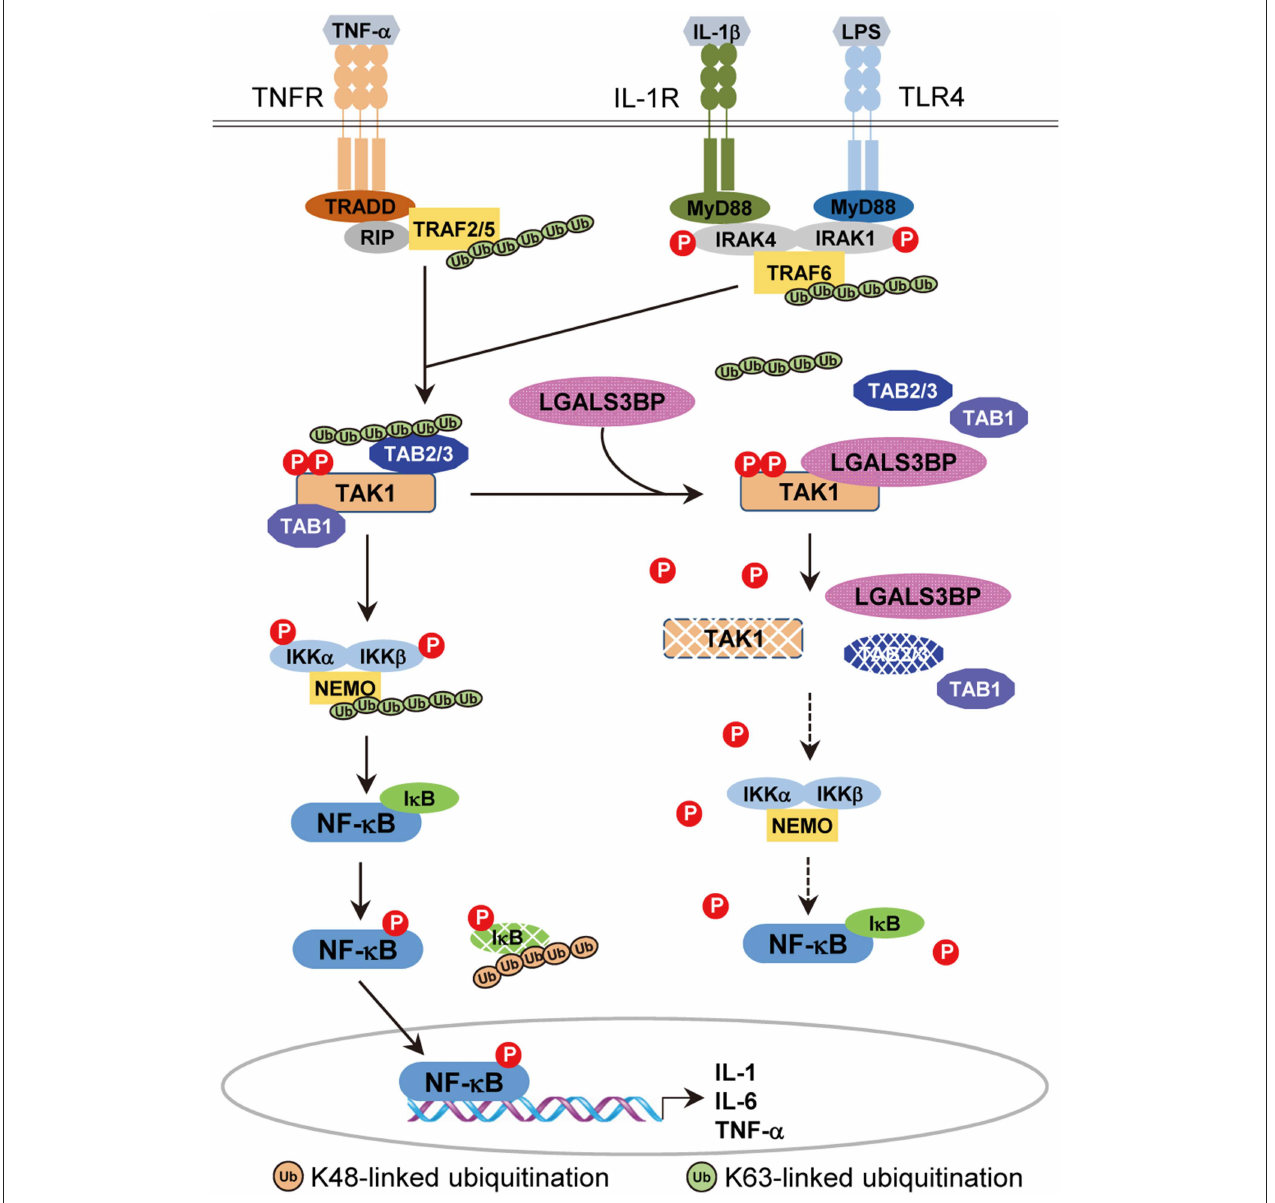
FIGURE 6 | A model of the inhibitory effect of Gal-3BP on TAK1-dependent NF- κ B signaling pathway. TNF- α binds with its specific receptor, TNFR, and then recruits tumor necrosis factor receptor-associated death domain protein (TRADD), receptor-interacting protein 1 (RIP1), and TNF receptor-associated factors 2/5 (TRAF2/5) to form a large receptor complex. Similarly, IL-1 and LPS bind with their specific receptors (IL-1R and TLR4) and recruit MyD88, interleukin-1 receptor-associated kinase 1/4 (IRAK1/4), and TNF receptor-associated factor 6 (TRAF6). TGF- β -activated kinase 1 (TAK1) is recruited by TRAF2/5 (in the TNF pathway) or TRAF6 (in the IL-1 and LPS pathways) and forms a complex with TAK1 binding protein 2 (TAB2) or TAB3, resulting in the phosphorylation and activation of inhibitor of NF- κ B (I κ B) kinases (IKKs). Activated IKKs phosphorylate and degrade I κ B proteins, leading to nuclear localization and activation of NF- κ B. Here, we speculate on the inhibitory effect of Gal-3BP on the TAK1-dependent NF- κ B signaling pathway. Gal-3BP interacts with TAK1 and inhibits its phosphorylation, leading to suppression of its kinase activity and protein stability. The effect of TAK1 inhibition eventually induces the inhibition of NF- κ B activation by the suppression of IKKs and activation of I κ B,